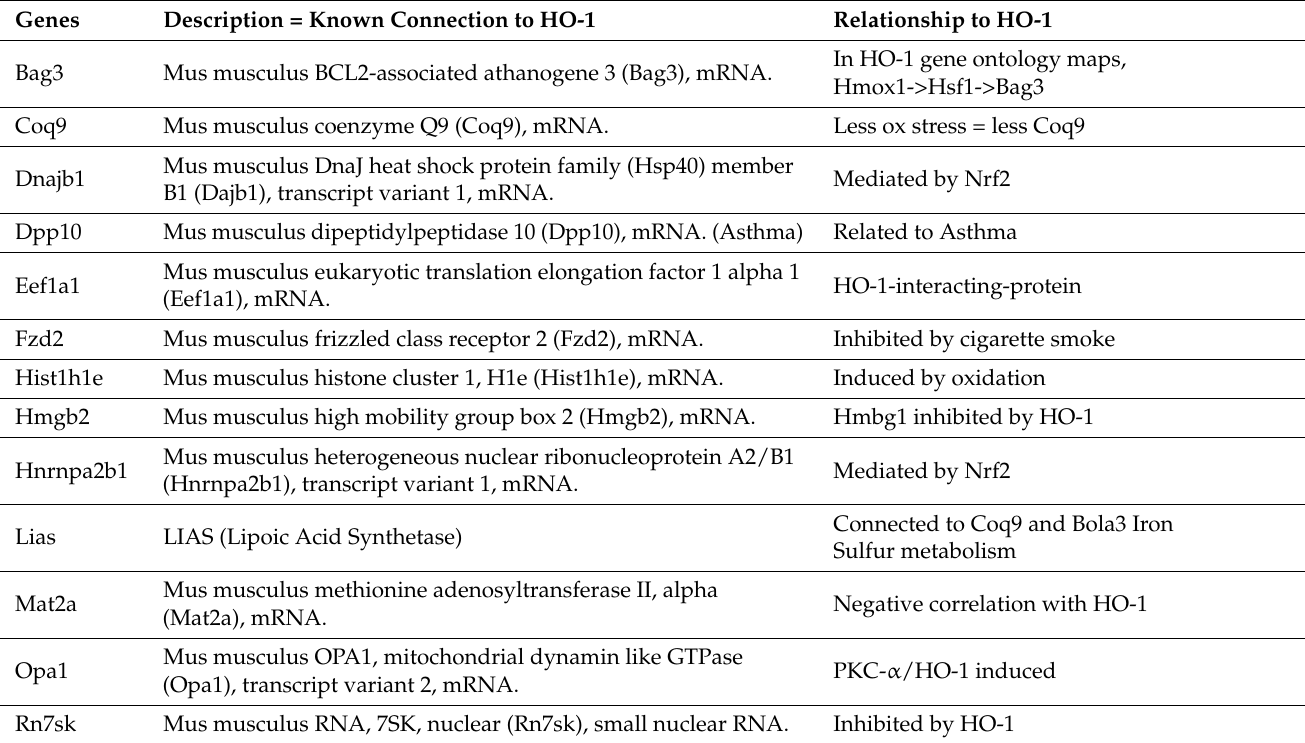
Table 1. Top 10% of genes with highest p -value probability of DNA binding to HO-1 and known literature interactions to